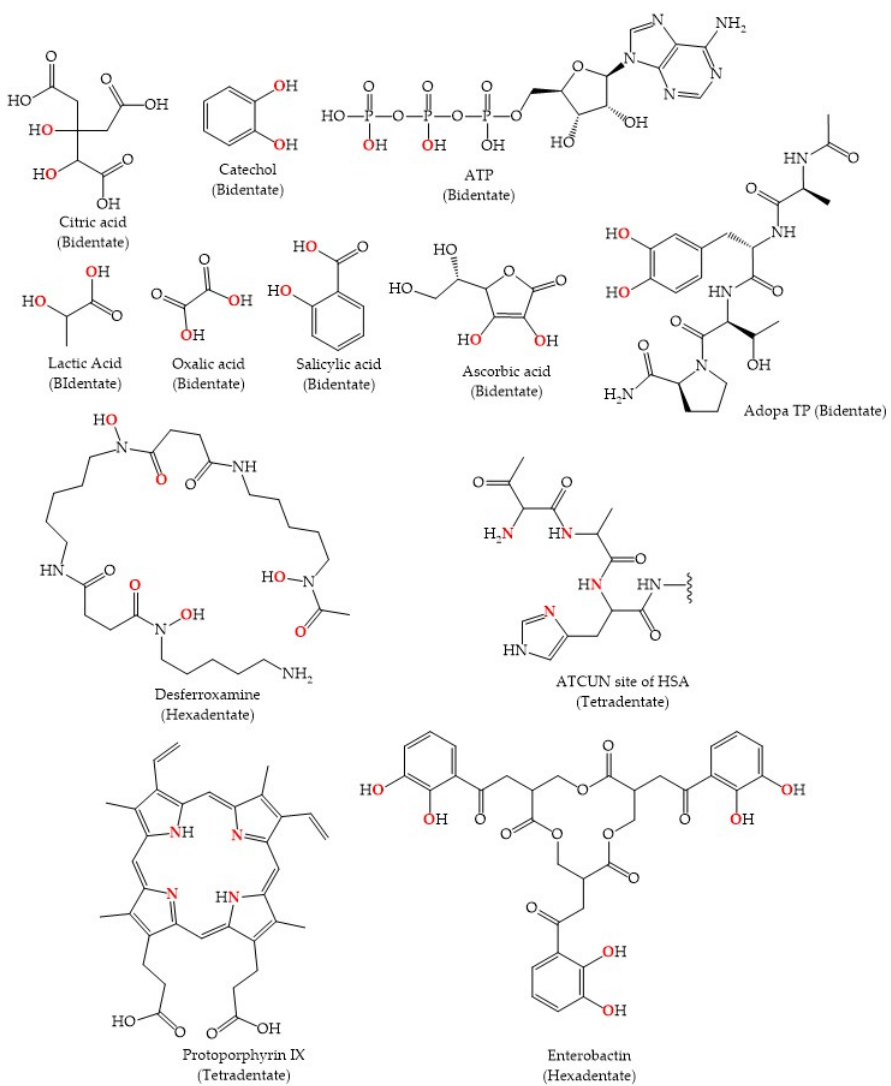
Figure 3. Some endogenous (or proposed) biological Ti(IV) chelators. Typical Ti(IV) binding moieties of endogenous ligands with some representative coordination modalities. Reprinted